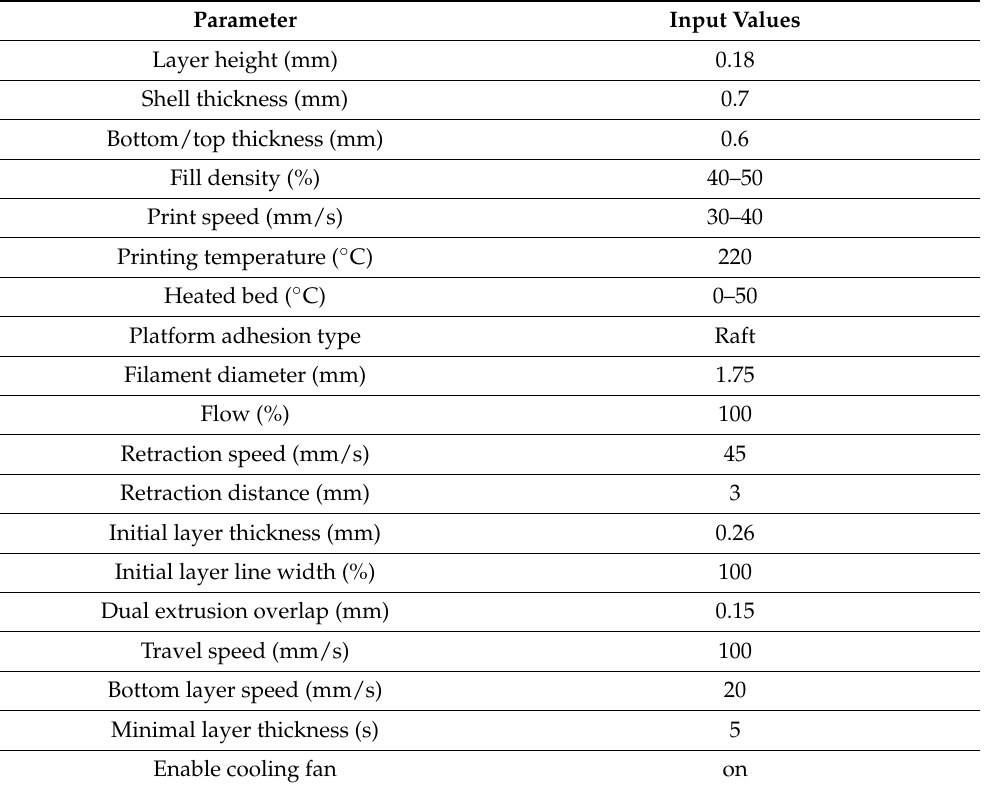
Table 6. Process parameters for making physical